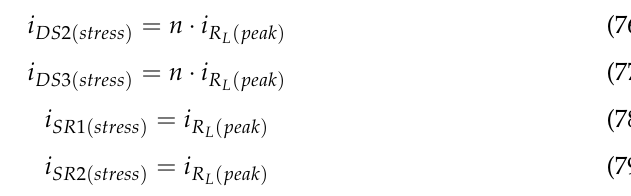
(82) Figure 15. Equivalent circuit operating during [0, DT ]. Mode 2 [ DT , 0.5 T ] The main switches S 1 , S 2 and S 3 are in the turned-off state. In this interval, the inductor L 1 releases energy to the capacitor C 1 , and the output inductor L 2 changes into the free- wheeling state, releasing energy to the output load R L . The equivalent circuit is shown in Figure 16 and the formulas are expressed as follows:  () = −[  +   +   ∙ (  +   )]